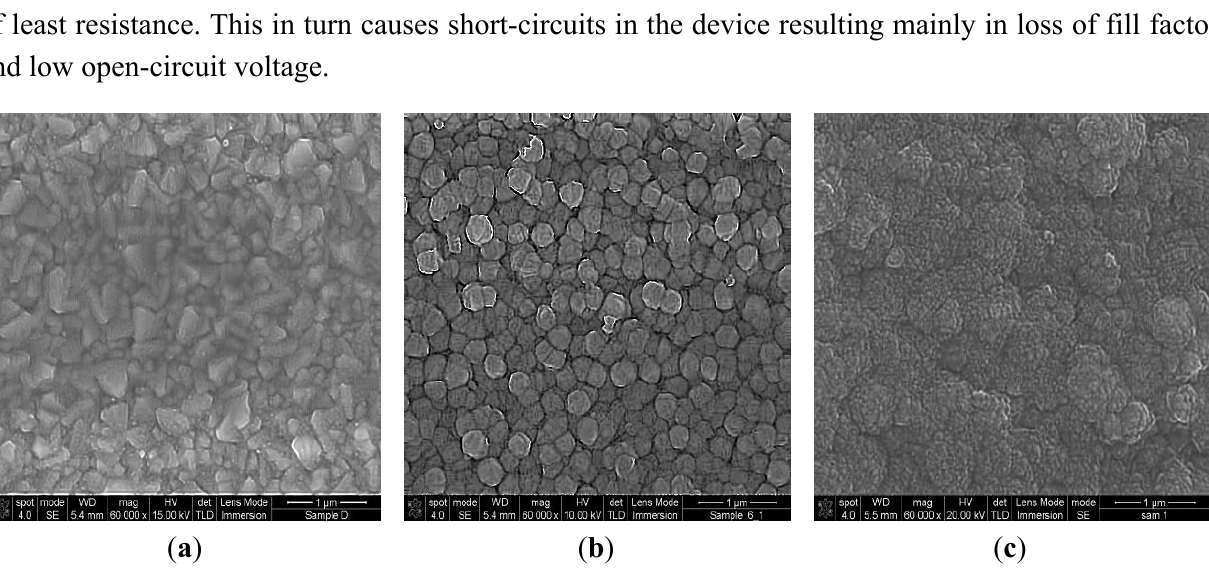
Figure 6. Scanning electron micrographs of electrodeposited ( a ) amorphous ZnS; ( b ) polycrystalline CdS and ( c ) highly oriented CdTe thin